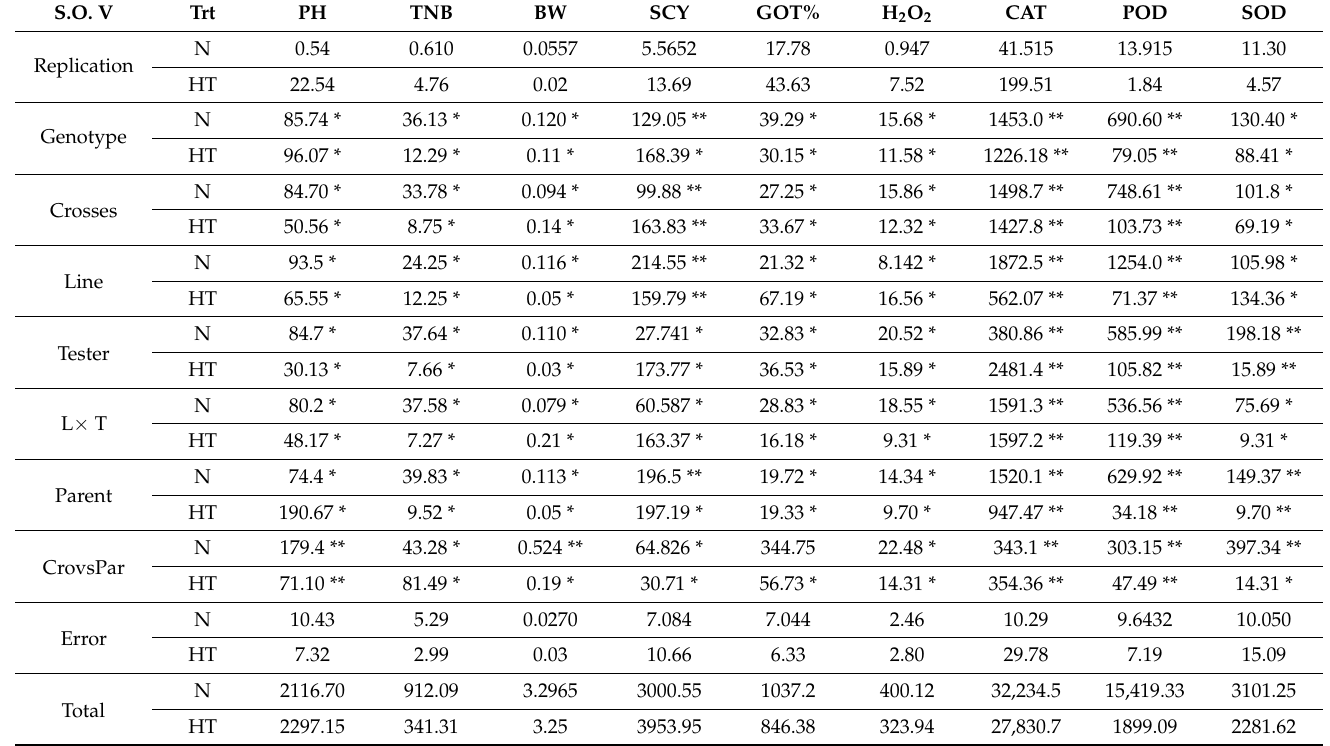
Table 6. Second year mean squares of line × tester analysis for various characters under normal and high temperature stress